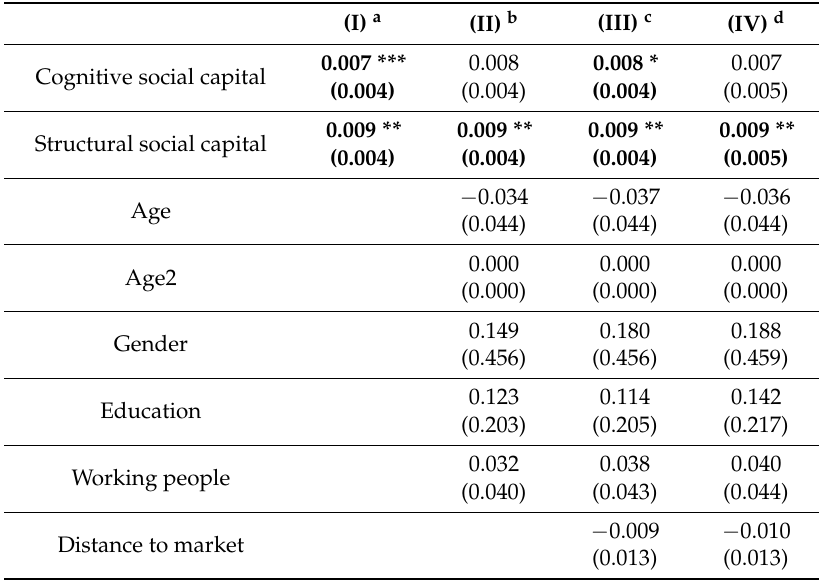
Table A3. Probit Model